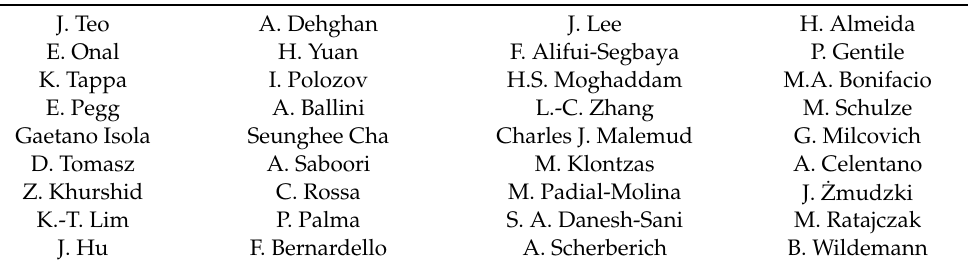
Table A1. Special Issue reviewer